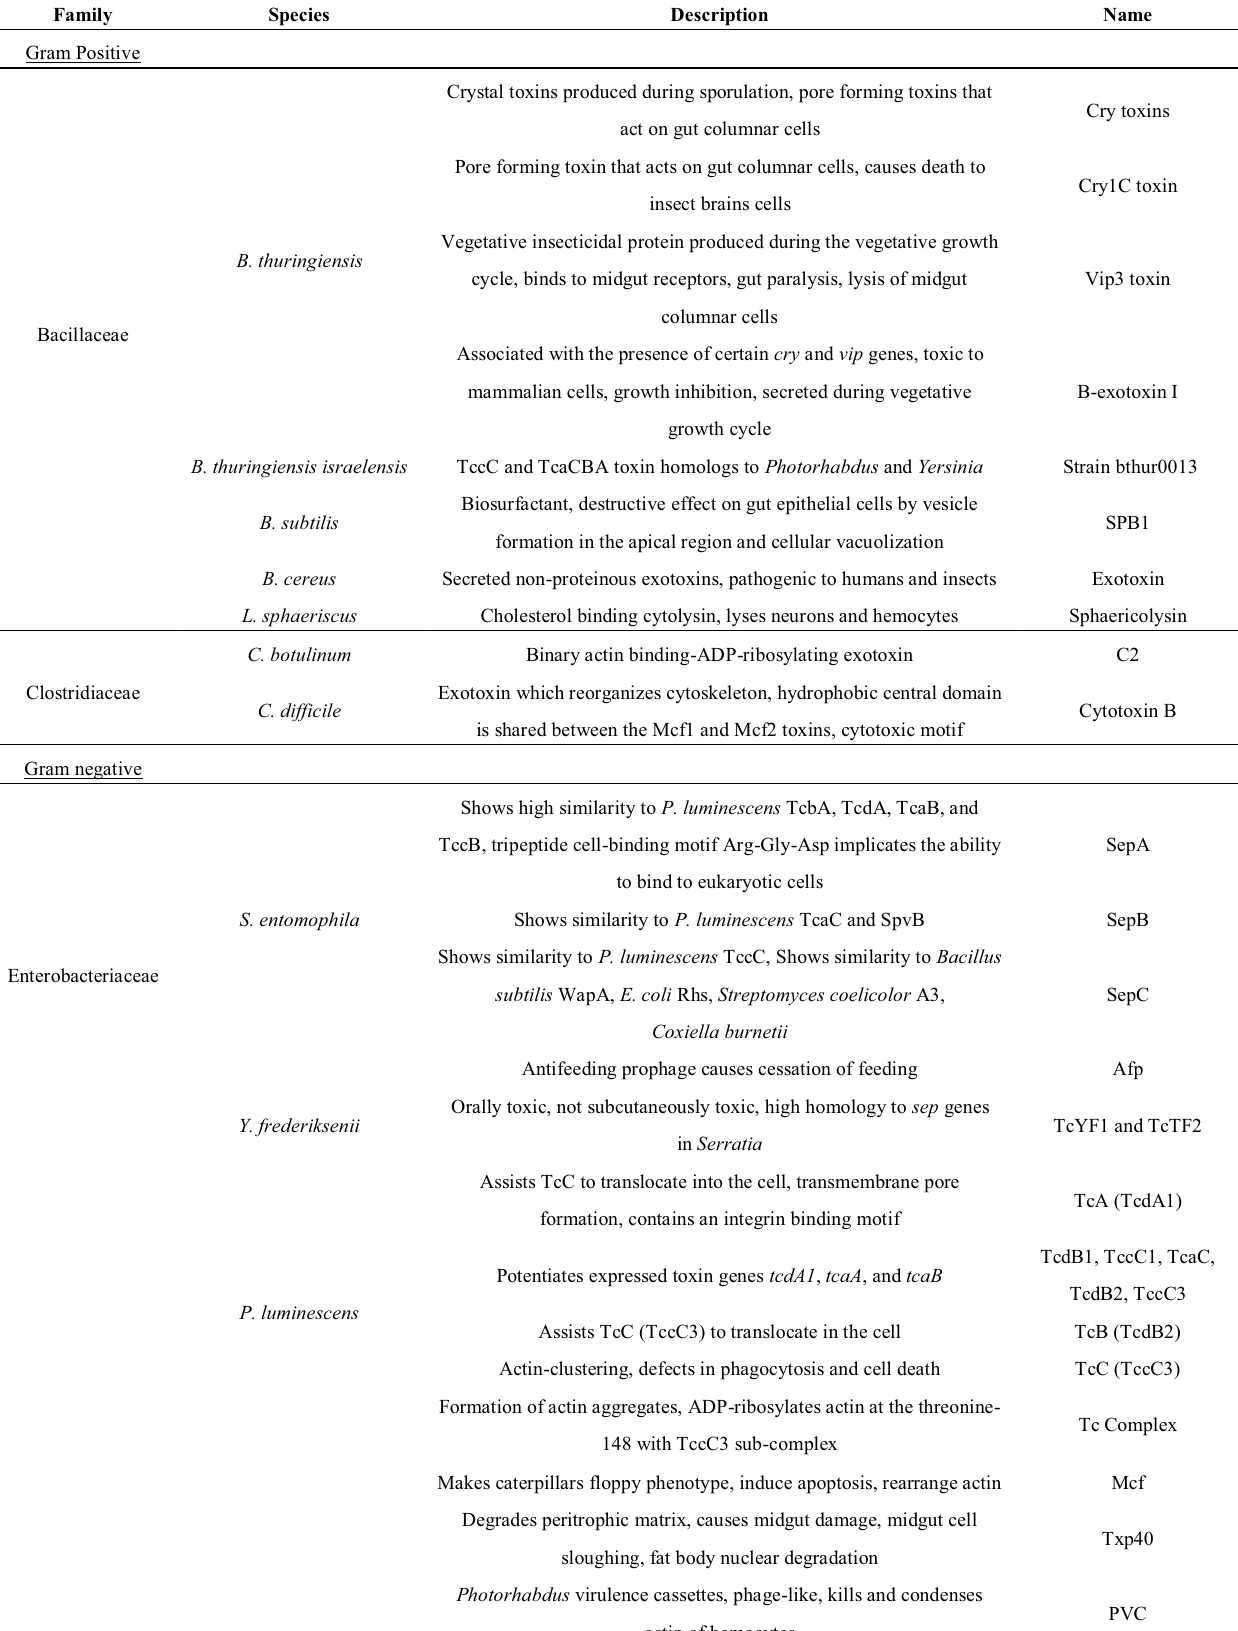
Table 1. Mode of action of entomopathogenic bacterial toxins with toxicity to lepidopteran larvae.